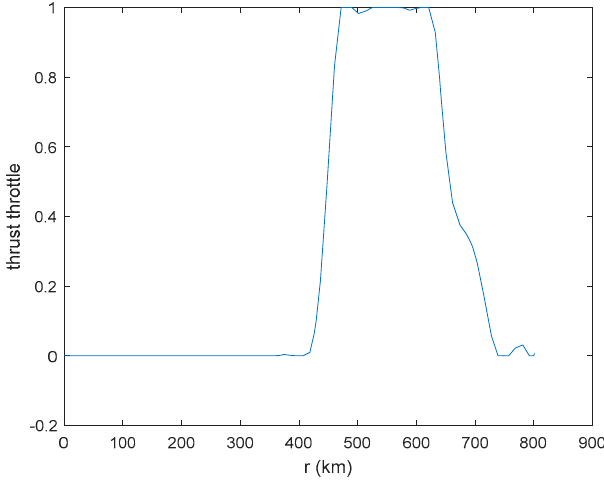
Figure 10. Optimal thrust throttle at the initial altitude of 43 km.